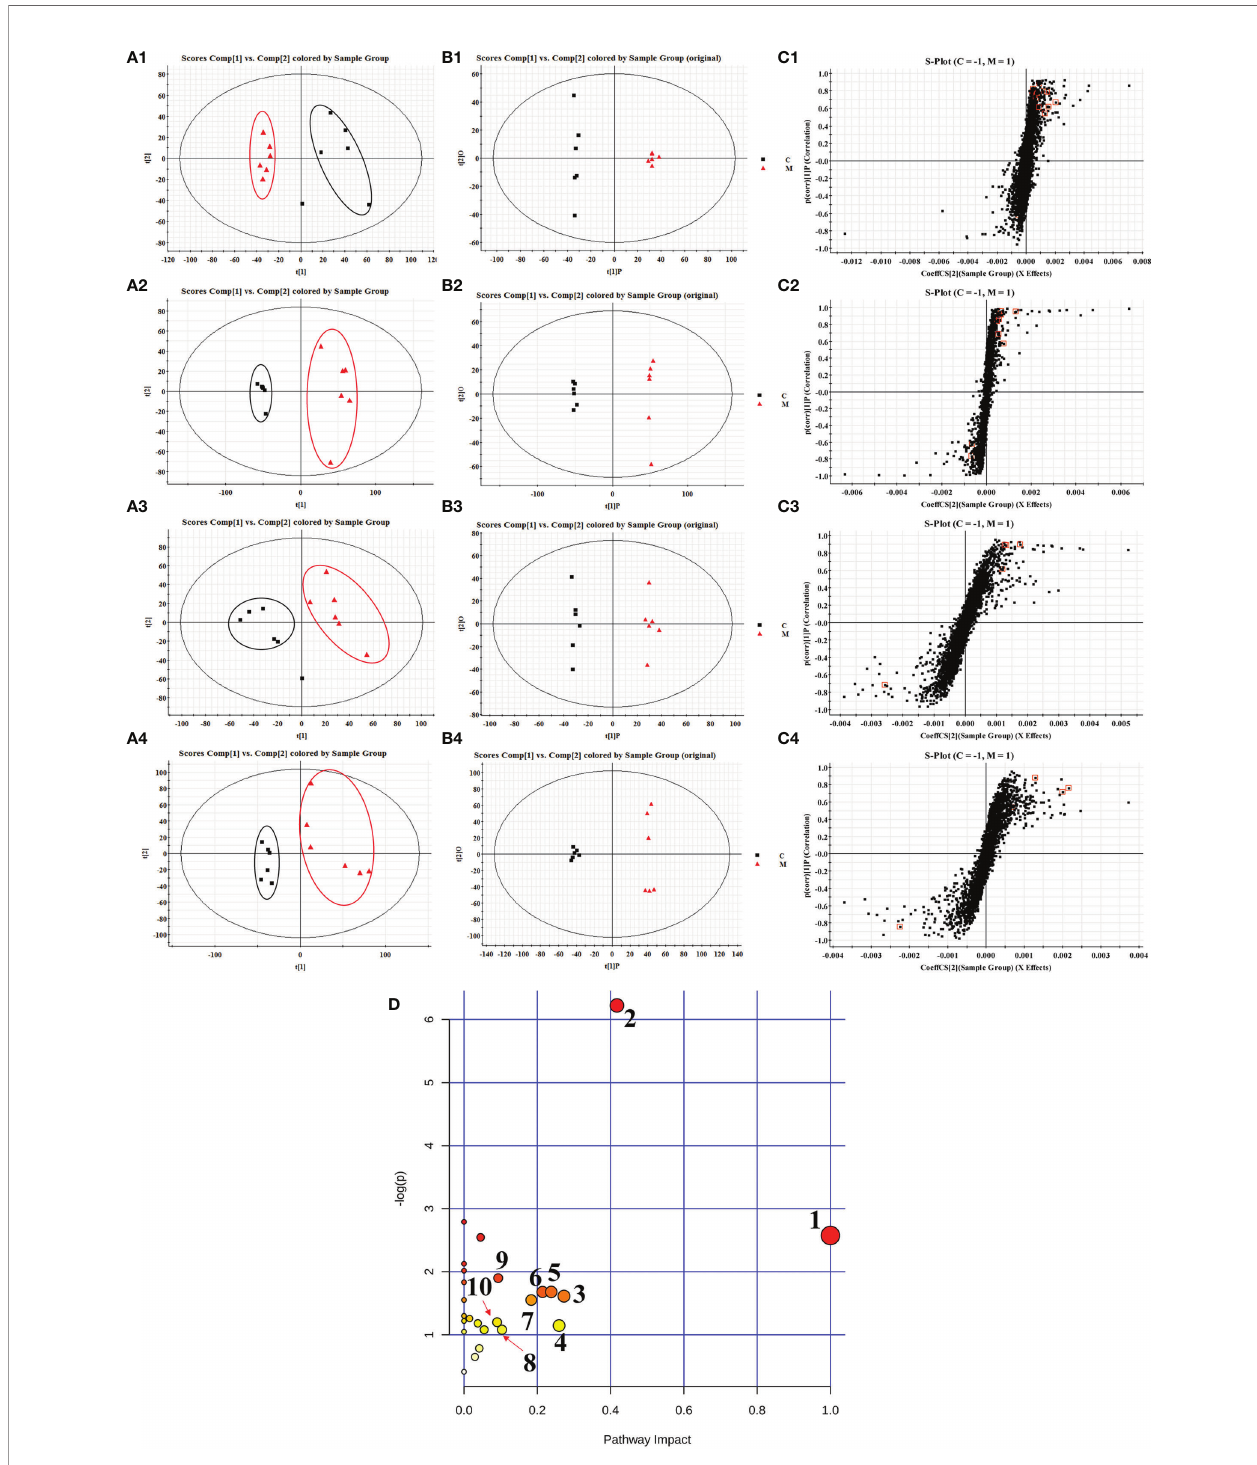
FIGURE 2 | PCA scores plots (A) , OPLS-DA scores plots (B) and S-plots of OPLS-DA (C) for plasma (1, 2) and urine (3, 4) of model group (red) vs. control group (black) in positive (1, 3) and negative (2, 4) ion mode; summary of pathway analysis in plasma and urine with MetPA (D) . (1) D-glutamine and D-glutamate metabolism; (2) retinol metabolism; (3) pentose and glucuronate interconversions; (4) alanine, aspartate and glutamate metabolism; (5) nicotinate and niacinamide metabolism; (6) ether lipid metabolism; (7) selenoamino acid metabolism; (8) glycolysis or gluconeogenesis; (9) arginine and proline metabolism; (10) steroid hormone